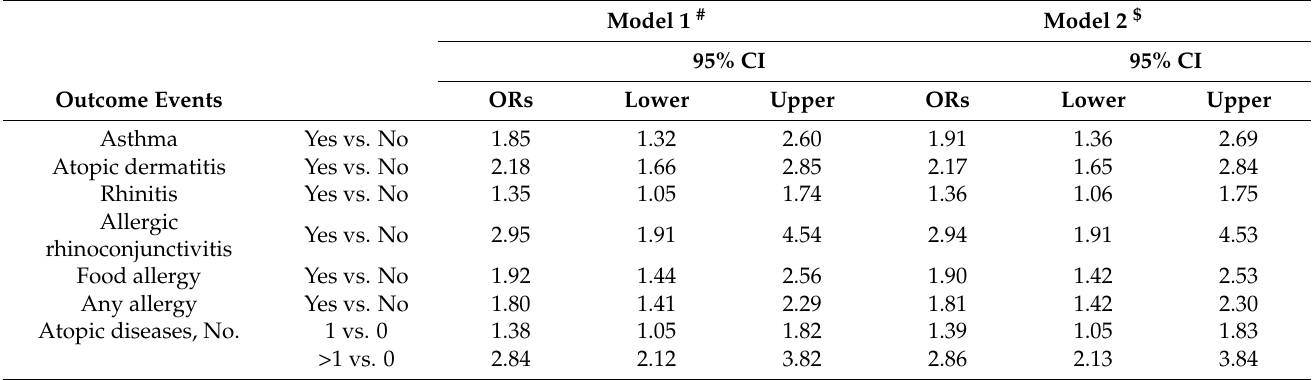
Table 1. Association between atopic diseases at 2 years of age and anemia at 3 years of age in Japanese